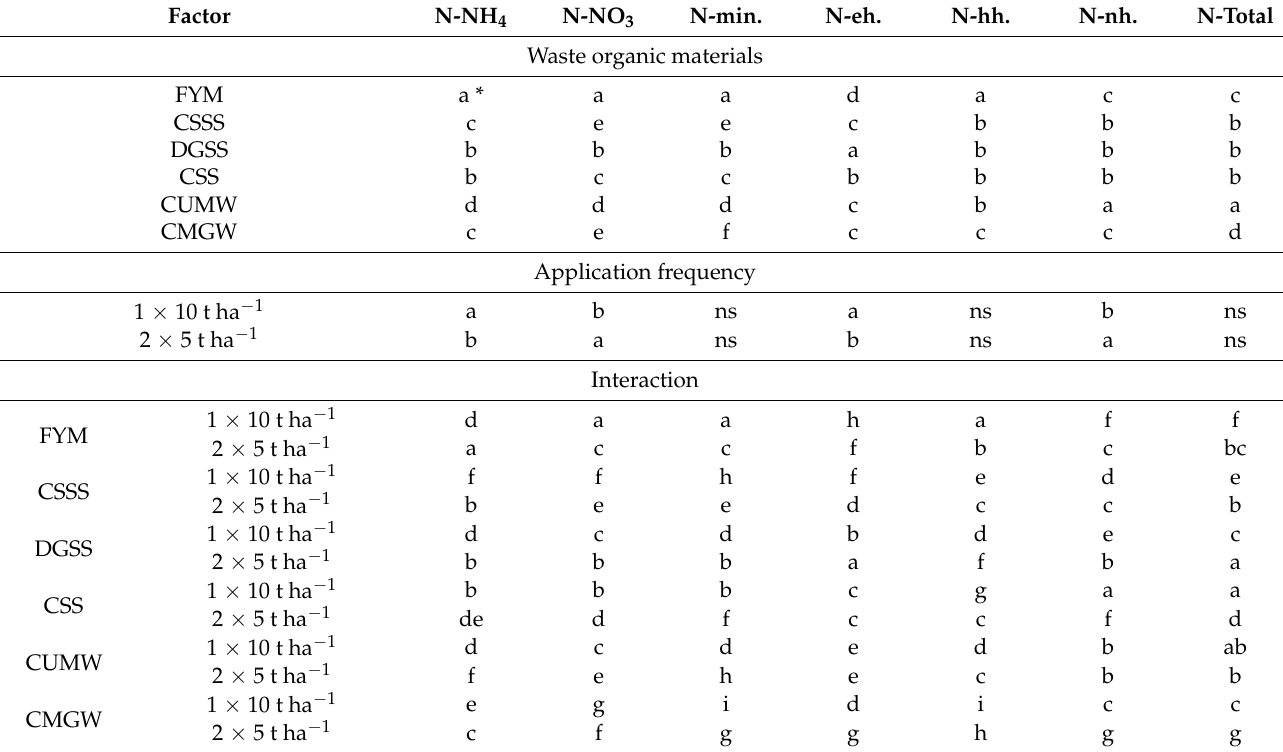
Table 3. Statistically significant differences the N content in the determined fractions (two-way-Anova).